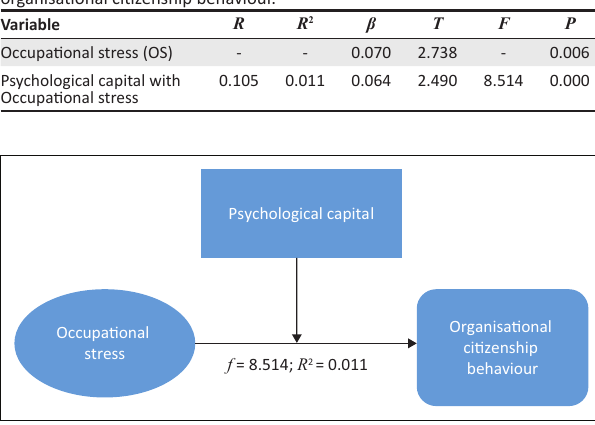
FIGURE 2: Relationship between occupational stress and organisational citizenship